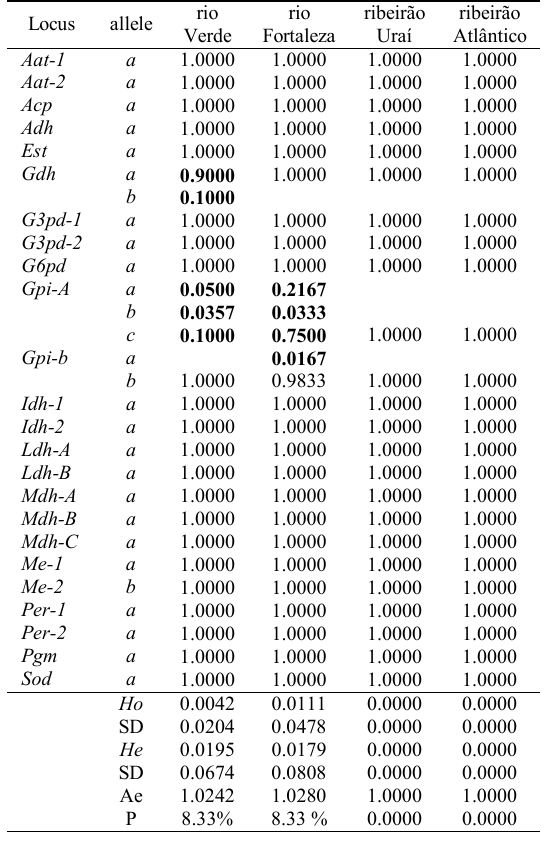
Table 2. Identity (above diagonal) and genetic distance (bellow diagonal) of Nei (1978) among four samples of Neoplecostomus yapo from the rio Paranapanema